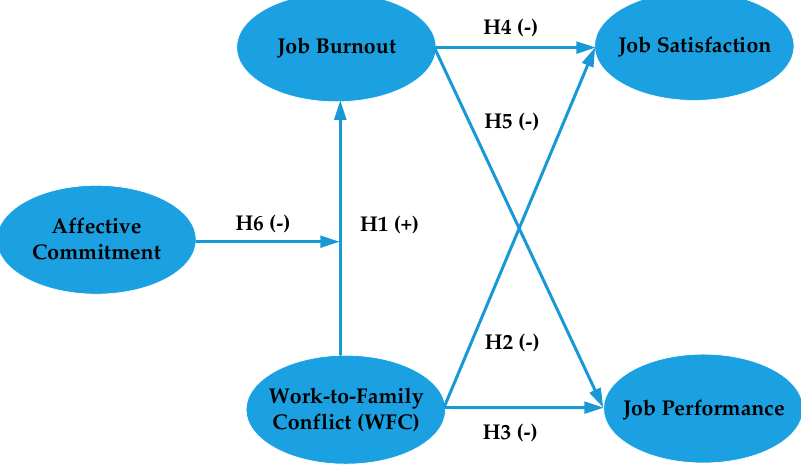
Figure 1. Theoretical model.